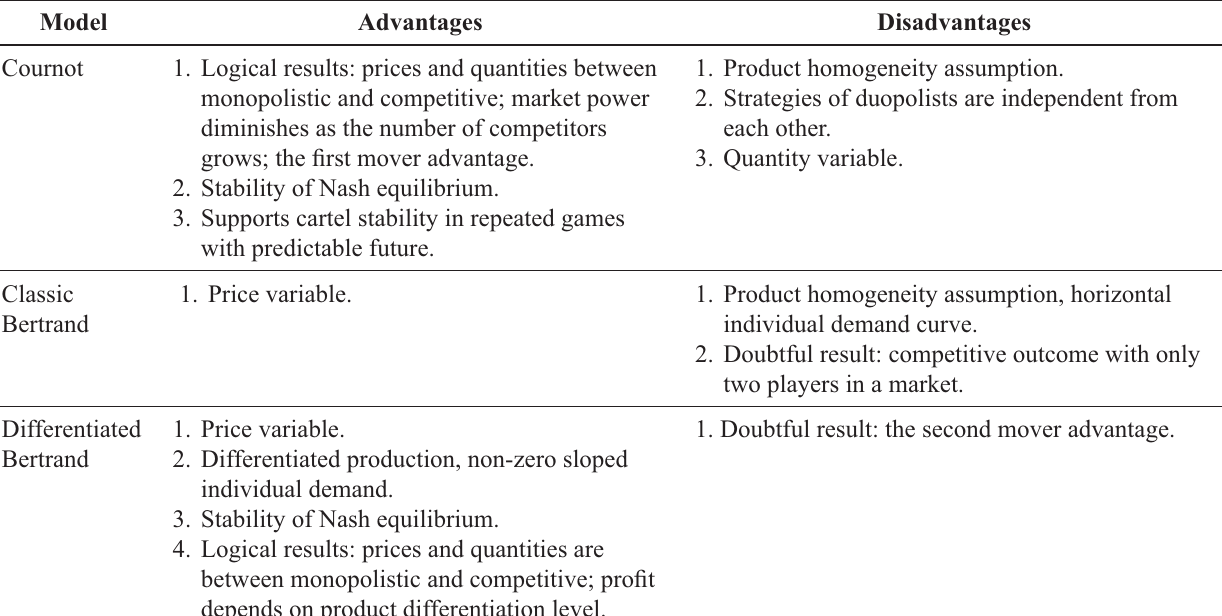
Table 4. The summary of the comparative analysis of the duopoly models Model